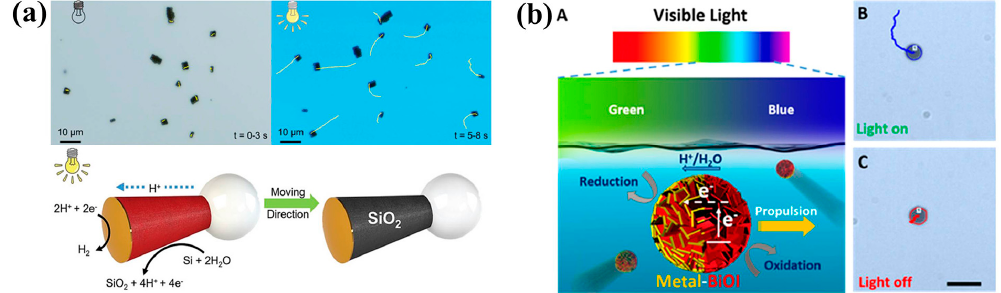
Figure 8. Visible-light-powered MNMs. ( a ) Trajectories of the Si–Au micromotors in water, from left to right, without illumination and with illumination at a light intensity of 13.6 mW mm − 2 (top figures). Propulsion mechanism of the Si–Au micromotors activated by visible light in deionized (DI) water (down figure). Reproduced with permission [102]. Copyright 2017, Royal Society of Chemistry; ( b ) Mechanism illustration of visible-light-driven BiOI-metal Janus micromotors (A) and the movement trajectories of BiOI-metal Janus micromotors with and without light irradiation (B,C). Reproduced with permission [80]. Copyright 2017, American Chemical Society.